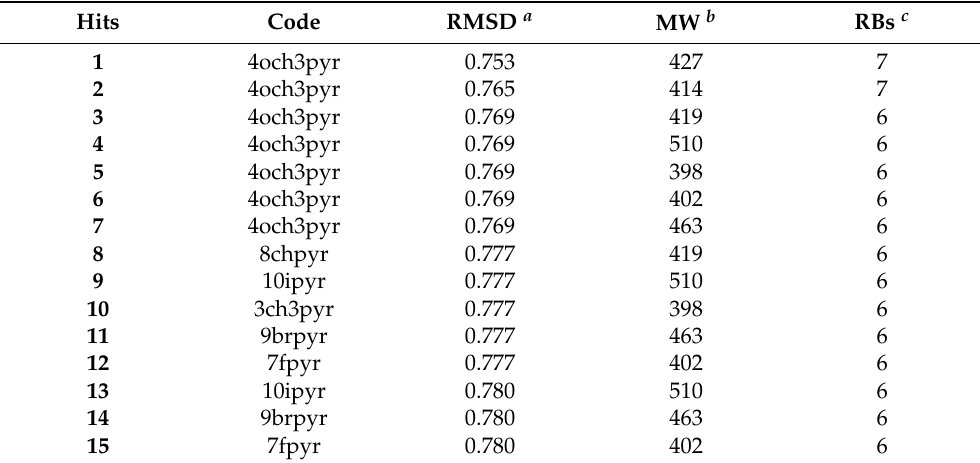
Table 1. The top fifteen hits 1 – 15 of the compound library ranked based on RMSD, MWs, and RBs.